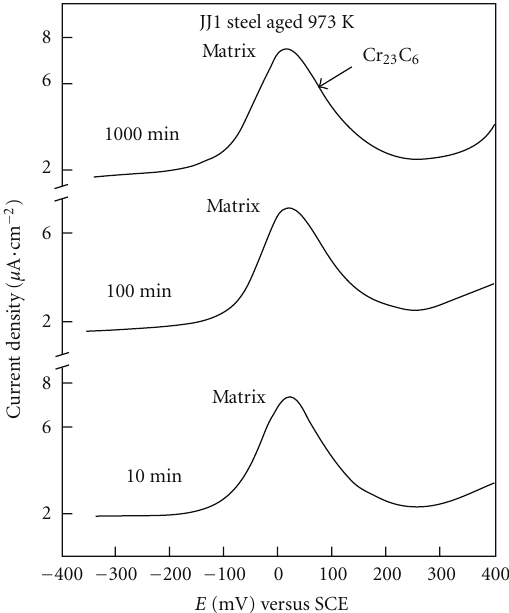
Figure 4: Anodic polarization curves of JJ1 steel aged at 973K for 10, 100, and 1000